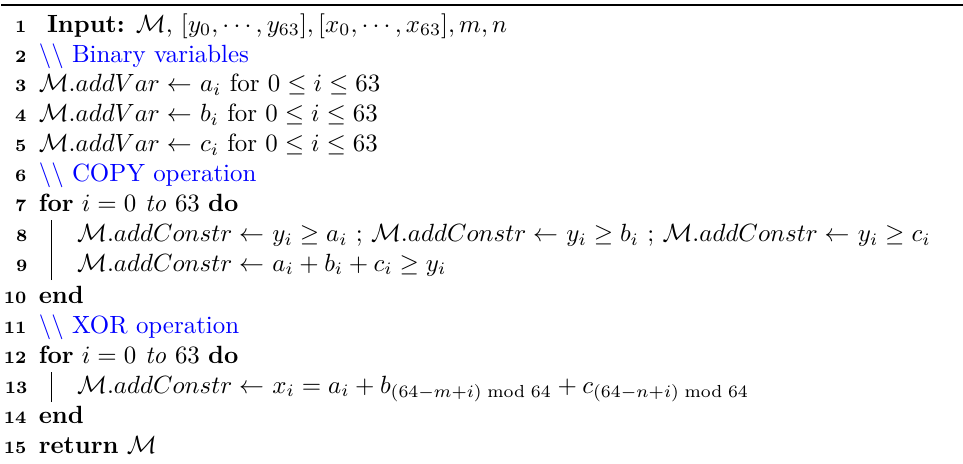
Algorithm 5: MILP model for the σ